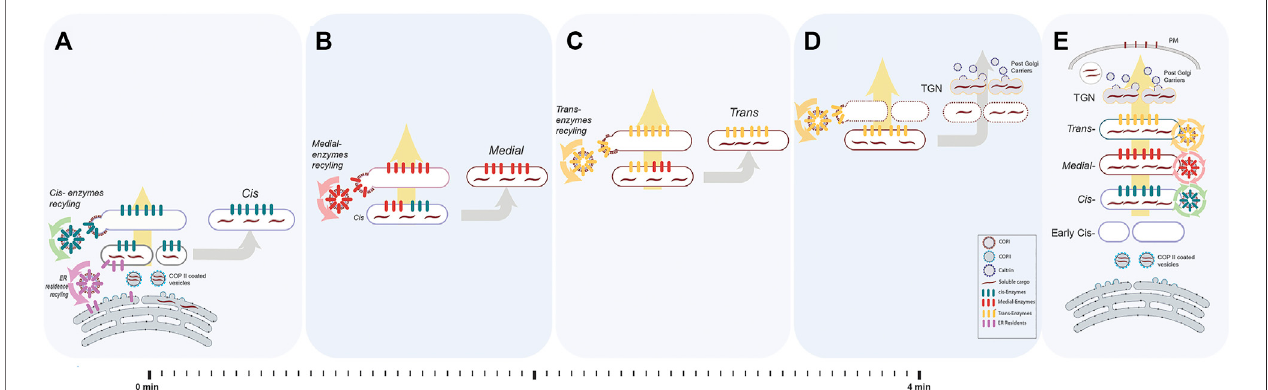
FIGURE2| Theprocessofcisternalprogressionandmaturation.Wedepictedanidealandasimpli fi edversionofthecisternalmaturationmodelforcommunication purposes.In this model, each enzyme recycle from the cisterna inwhichresides tothe proximal cisternawithin COPI-vesicles. Evidence from yeastshows that there are alternativerecyclingstepsthatuseCOPI-independentvesicles.Brie fl y,theGolgiinmammalsusuallycomprises3 – 6stackedcisterna( cis ,medialand trans ). (A) Oncethe cargo (dark maroon waves) arrives from ER in COPII coated vesicles (cyan coated round pro fi les containing short dark maroon waves representing cargoes), they fuse and form early cis- compartment. At the same time, cis -resident glycoenzymes (green bars) are recycled back (green arrows) from pre-existing cis to the newly forming cis inCOPIcoatedvesiclescontributingtoformationofthenew cis -cisterna.There,ERresidentproteins(pinkbars)andmembranesarerecycledbacktotheER via COPI-dependent vesicles (pink arrows). At the same time, a trans -cisterna disassembles into anterograde carriers (D) . (B) The newly formed cis- cisterna receivesthemedial-enzymes(redbars)whicharerecycling(redarrows)fromthepre-existingmedial-cisternatoforma cis/medial hybrid.Fromthishybridcompartment, the cis- glycoenzymes(greenbars)arerecycledback(green arrows)toanewarriving cis- compartment(asin A )andthemedial-glycoenzymes(redbars)aretheonlyone to beleft inthemature medial-cisterna. (C) Similarly, thenewly formed medial-cisterna receives the trans -glycoenzymes (yellow bars) which arerecycling (yellow arrows) fromthepre-existing trans -cisternatoformamedial /trans hybrid.Fromthishybridcompartment,themedial-glycoenzymes(redbars)arerecycledback(redarrows)toa newformedmedial-compartment(asin B )andthe trans -glycoenzymes(yellowbars)aretheonlyonetobeleftinthemature trans -cisterna. (D) Throughallthesteps,the cargo never leaves the cisterna rather, it progresses anterogradely (large yellow arrow) along with maturing cisterna. Glycoenzymes (represented as coloured bars speci fi c for each cisterna) also move forward within progressing cisterna, but, once reached the appropriate intra-Golgi compartment, are retrieved, and recycled via COPI coated vesicles, driving the inter-conversion of the cis -cisterna into medial - and trans -elements (as in A – C ). Once cargo reaches the trans -face of Golgi, the TGN will be disintegrated into the post-Golgi clathrin coated vesicles containing cargo. (E) This happens in synchrony with cisternal progression. As a result, the cargoes moving forward are successively exposed to the enzymatic complement of each cisterna. The balance between the opposing anterograde and retrograde membrane fl uxesresultsinthecyclingofenzymesbetweentwospeci fi ccisterna(yellowcircleindicatesrecyclingfromthe trans- tothemedial-cisterna,redcirclefromthemedial-to the cis -cisterna, green circle from the cis to the new forming cis -cisterna and pink arrows from the newly formed cis -cisterna to the ER) and determines the sub-Golgi localisation of the glycoenzymes.